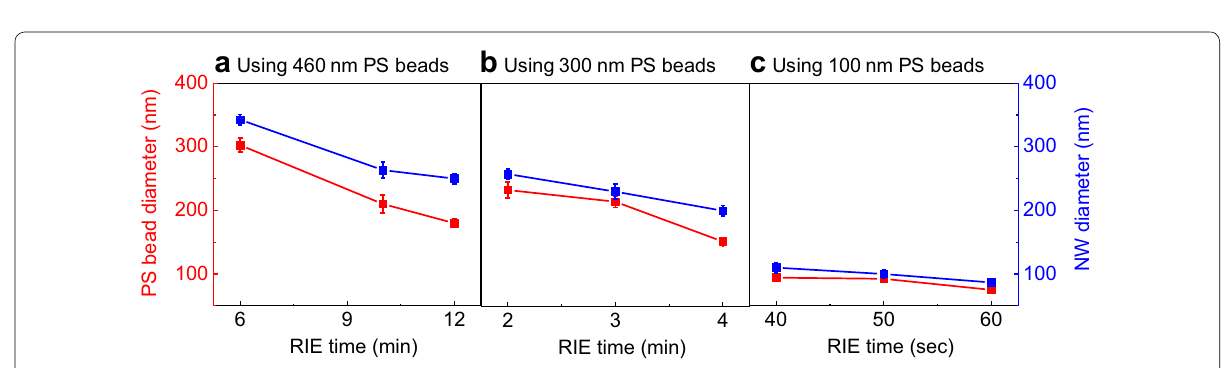
Fig. 3 Variations of diameter of Si NWs formed with PS beads with diameters of a 460, b 300, and c 100 nm as a function of etching